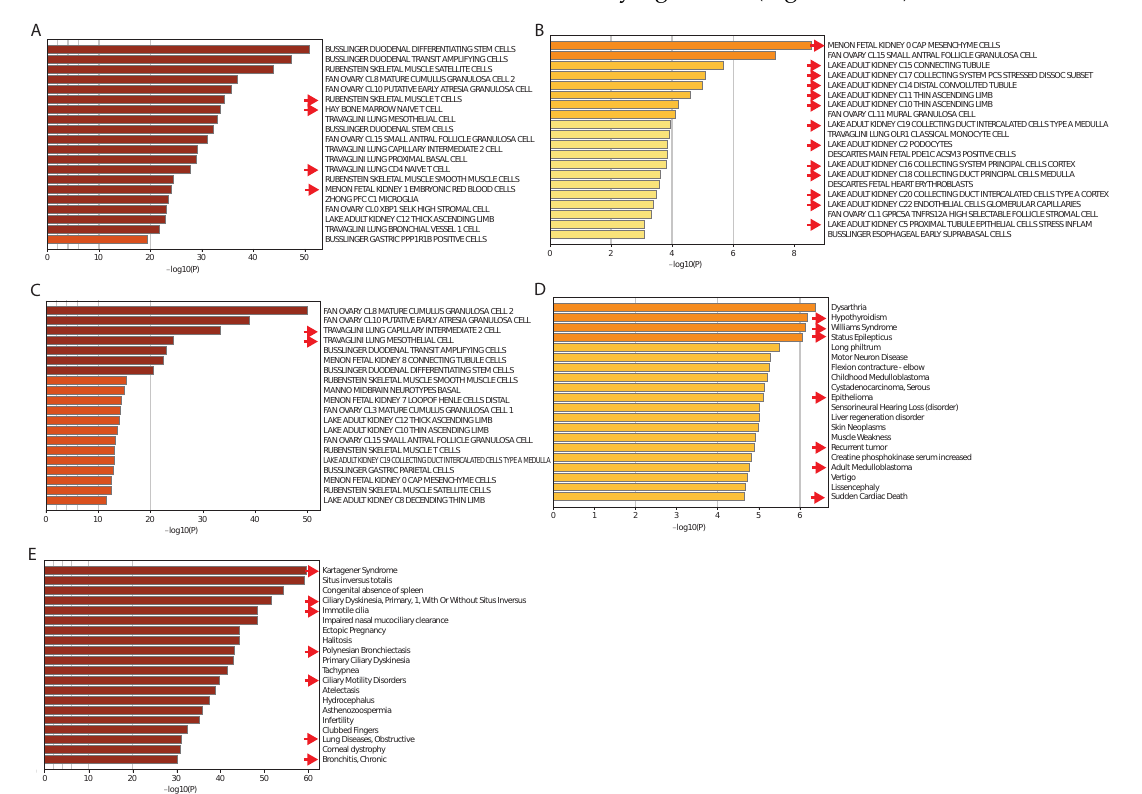
Figure 4. Summary of enrichment analysis in cell types of tissue-specific regulatory modules of ( A ) blood, ( B ) kidney and ( C ) lung. Examples of enrichment analysis of tissue-specific regulatory modules of ( D ) KIRP and ( E ) LUAD in DisGeNET. Red arrows in ( A – C ) depict cell-type and tissue-related terms and disease-relevant terms in ( D , E